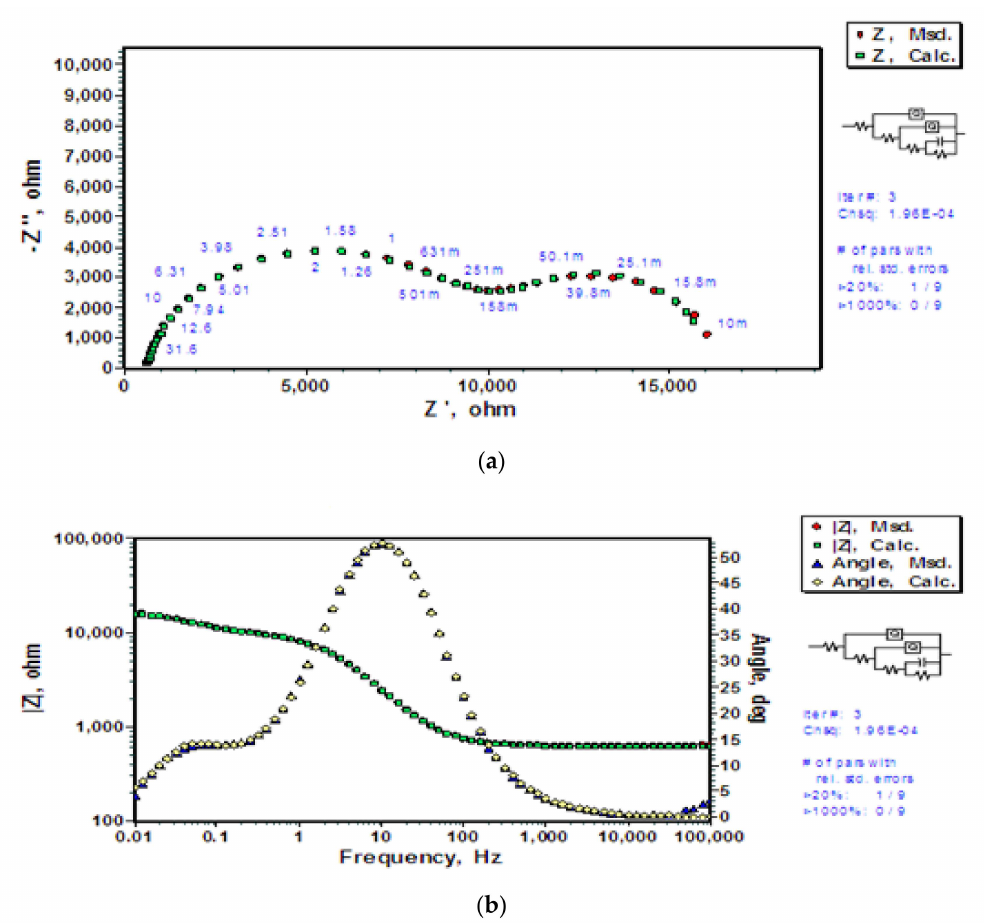
Figure 8. Experimentally measured and the corresponding data calculated using the electrical equivalent circuit, R s (Q Si (R Si (Q h (R h (C dl R dl ))))) for coated AZ91D alloy pre-dipped in hydroxide for 48 h followed by BTSE coating and then exposed to Na 2 SO 4 solution: ( a ) Nyquist plots, and ( b ) Bode and phase angle